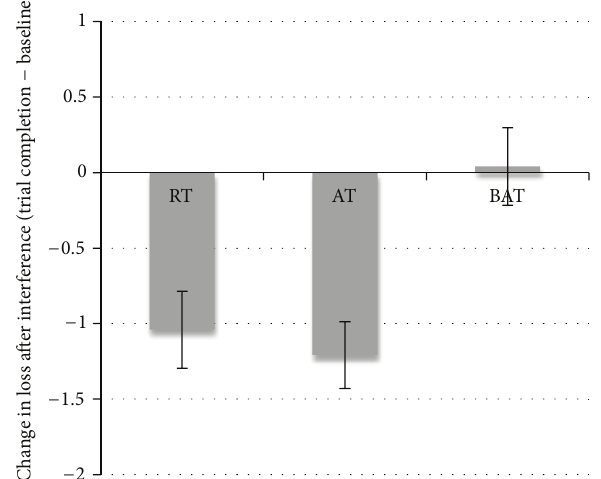
Figure 2: Change between baseline and trial completion in loss after interference on the RAVLT as a function of exercise group. The AT group showed significantly more change compared to the BAT group. Error bars represent standard error of the